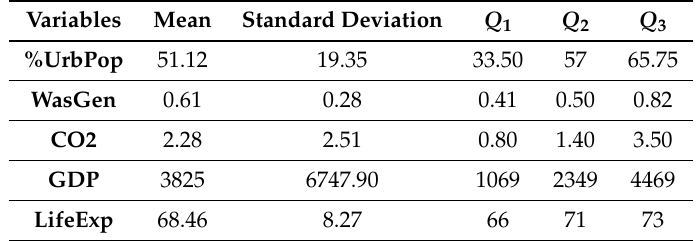
Table 3. Descriptive statistics of quantitative variables.